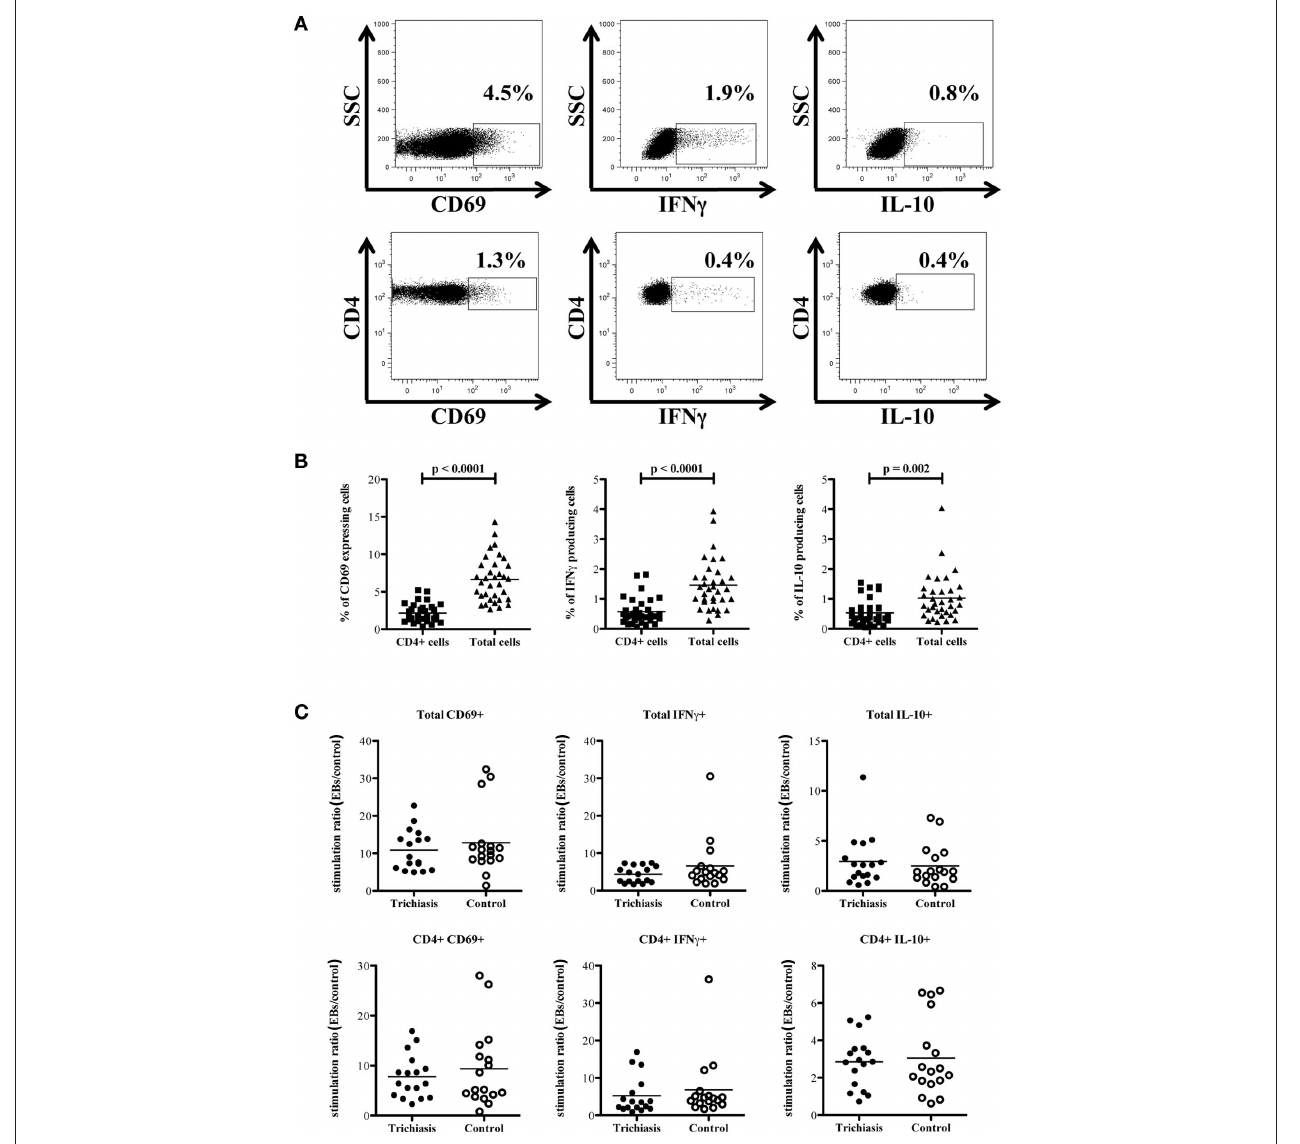
CD4 + IFN γ+ , CD4 + CD69 + , and CD4 + IL-10 + cells in all trichiasis cases and controls ( n = 34), indicating that CD4 + T cells are not the only source of IFN γ , IL-10, and activated cells. (C) Responses from trichiasis cases ( n = 17) and controls ( n = 17) represented as a stimulation ratio (as in Figure 3 ). The ratio of CD4 + activated (CD69 + ) or IFN γ+ /IL-10 + cells are slightly higher in the control group but the difference is not significantly